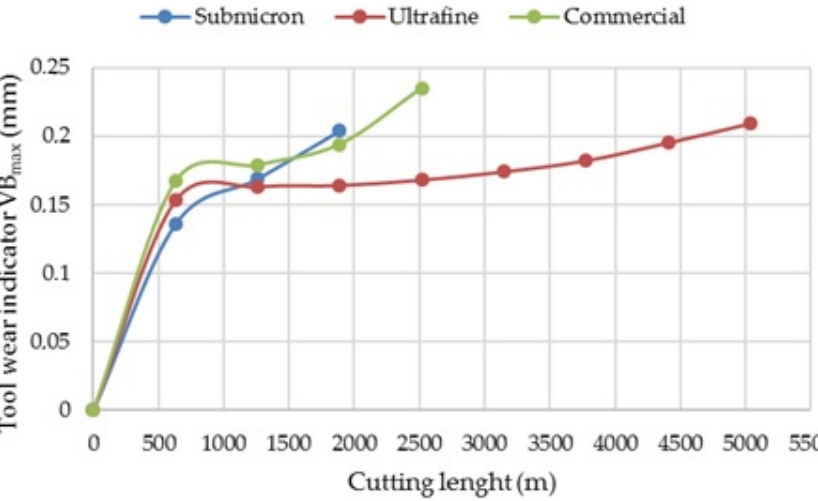
Figure 10. Example wear curves of the tested blades.